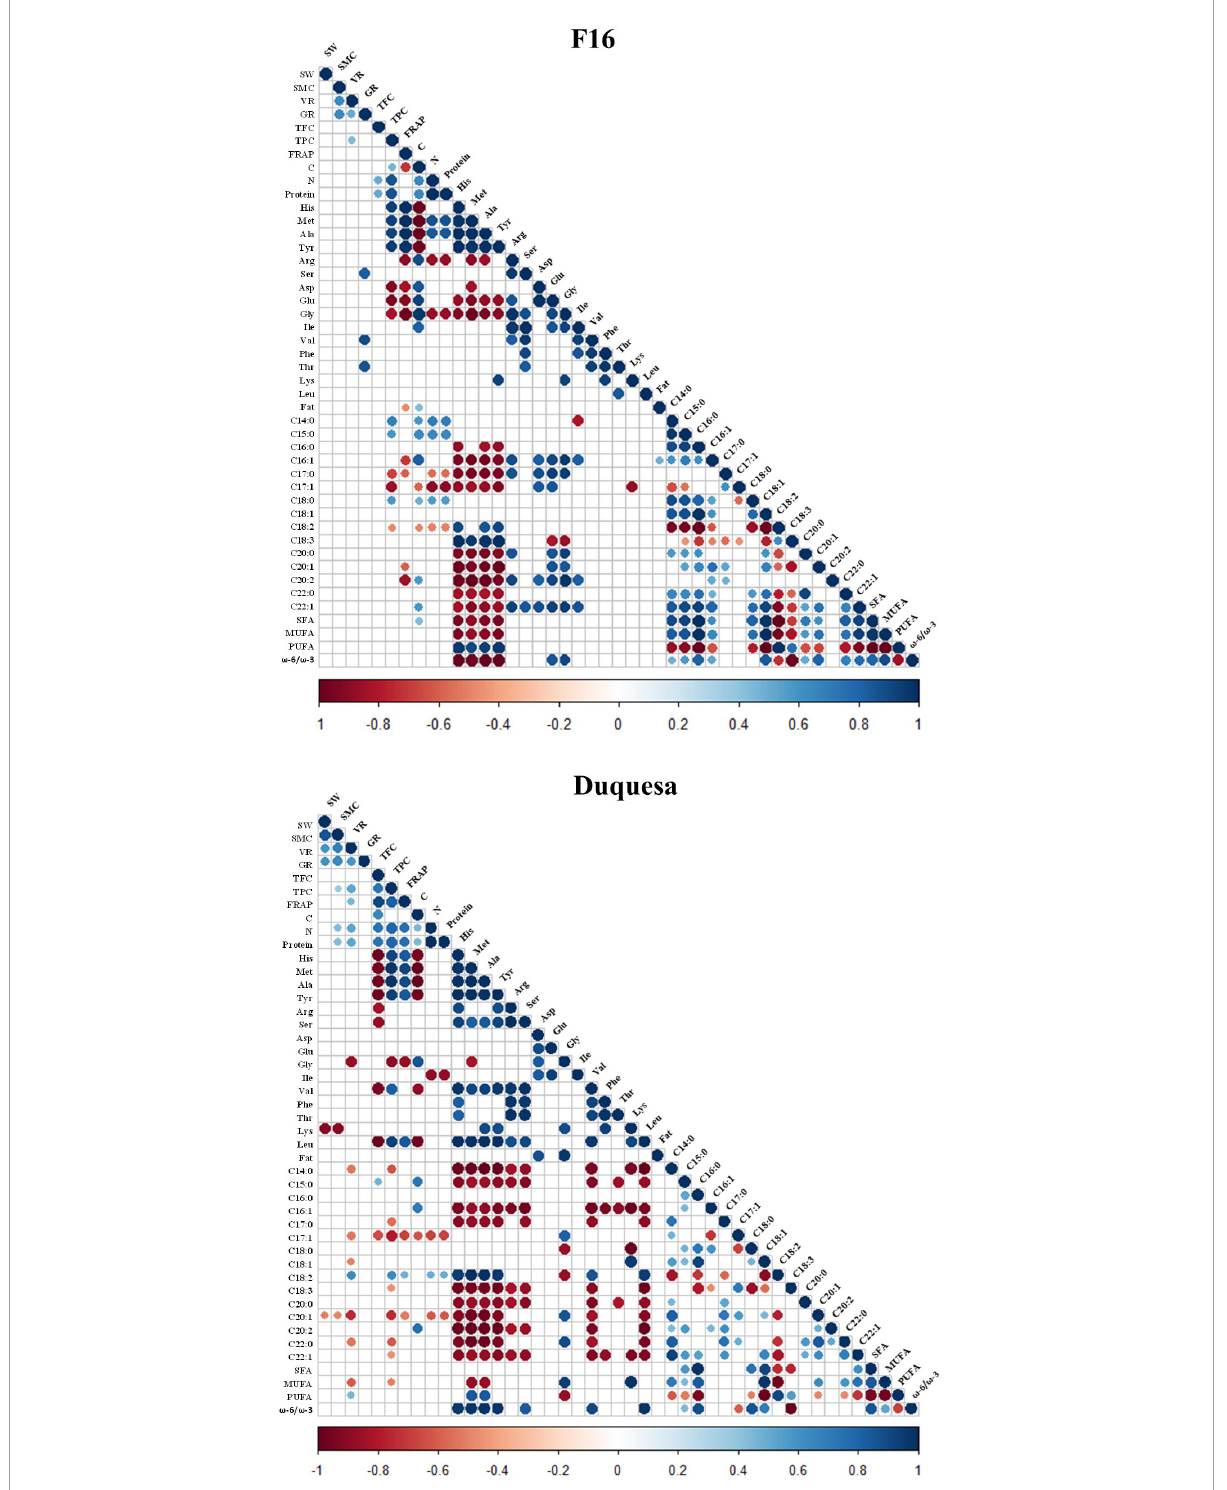
FIGURE6 Correlogram of quinoa seed quality variables. r coefficient of correlations of variables measured in F16 (top) and Duquesa (bottom) seeds, with a significance of p < 0.05. Blue circles show positive correlations while red circles indicate negative correlations. SW, 1000 seeds weight; SMC, seed moisture content; VR, viability rate; GR, germination 1 date after sowing; TPC, total phenolic content; FRAP, antioxidant power; C, carbon content; N, nitrogen content; C14:0, myristic acid relative content; C15:0, pentadienoic acid relative content; C16:0, palmitic acid relative content; C16:1, palmitoleic acid relative content; C17:0, margaric acid relative content; C17:1, margaroleic acid relative content; C18:0, stearic acid relative content; C18:1, oleic acid relative content; C18:2, linoleic acid relative content; C18:3, α -linolenic acid relative content;